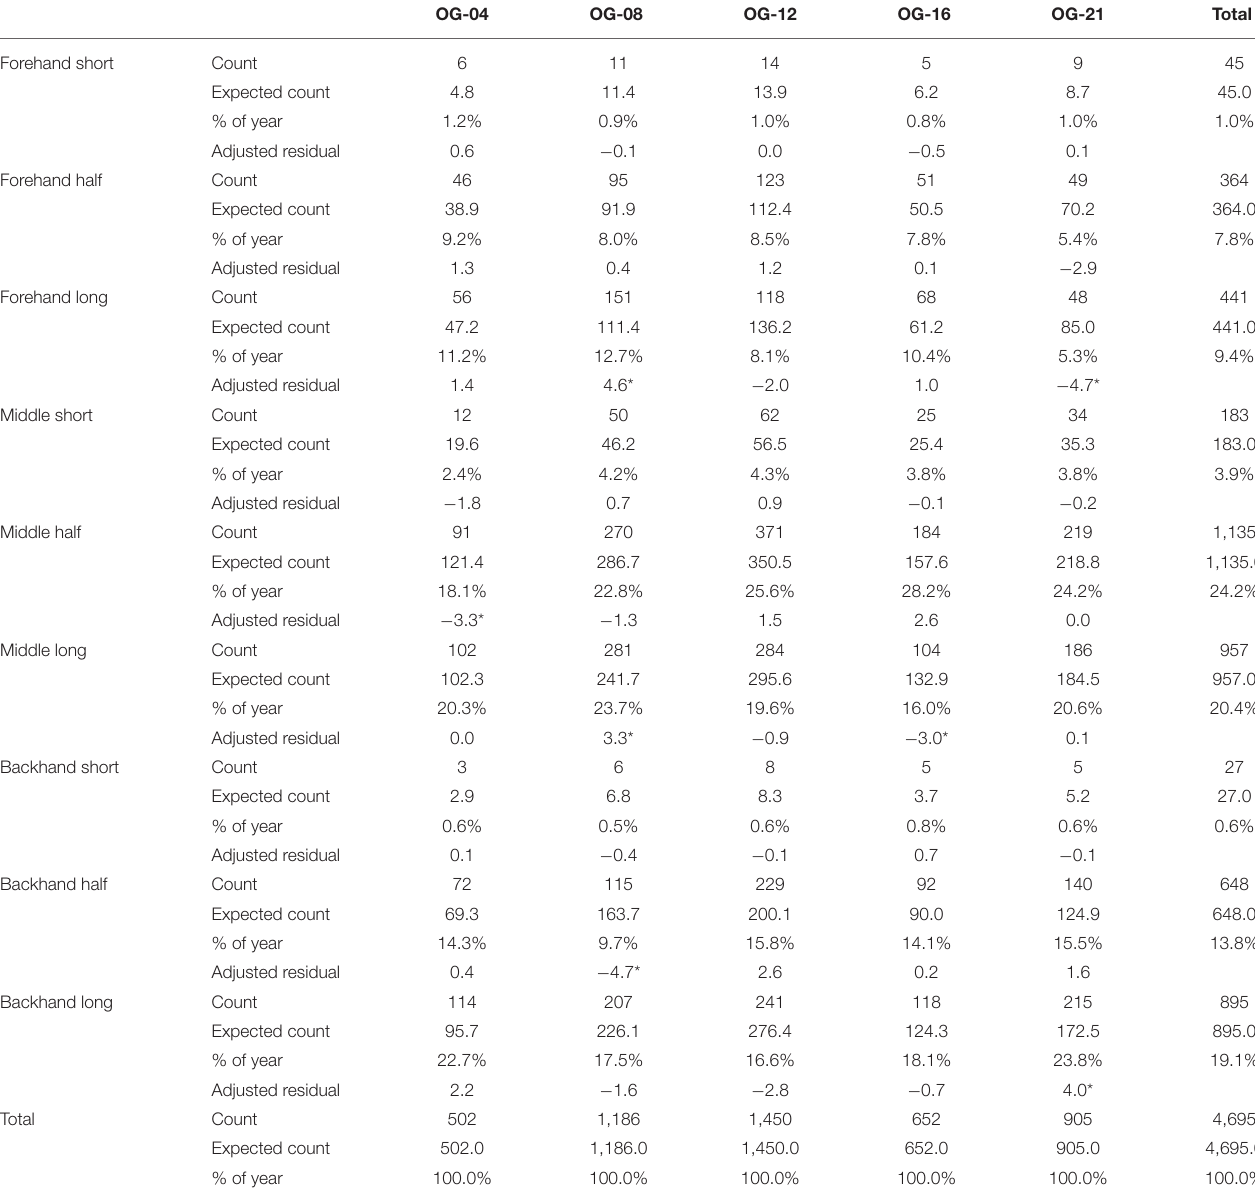
TABLE 3 | The ball placement throughout the different Olympic Games from 2004 to 2021. OG-04 OG-08 OG-12 OG-16